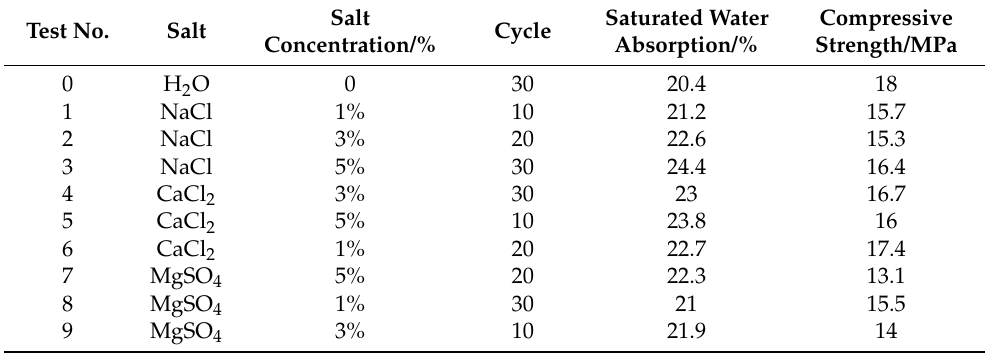
Table 4. Results of orthogonal